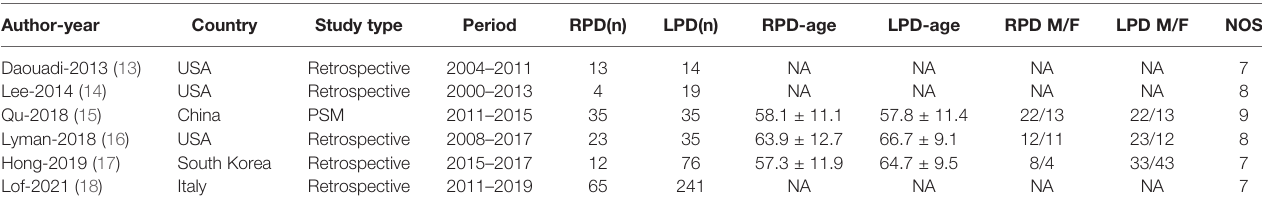
TABLE 1 | The main characteristics and NOS of the included